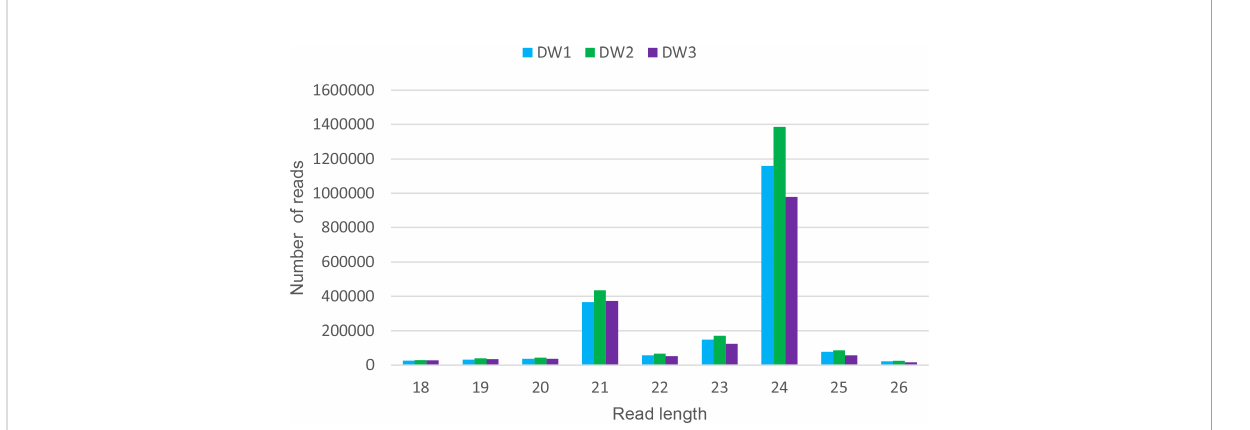
FIGURE 1 Read length distribution of the three Don Walter sRNA libraries. For each read length, the absolute read count per individual library is shown. The x-axis shows read lengths, and the y-axis shows the frequency of occurrence of reads of each length. The over-representation of 21 and 24 bp reads is